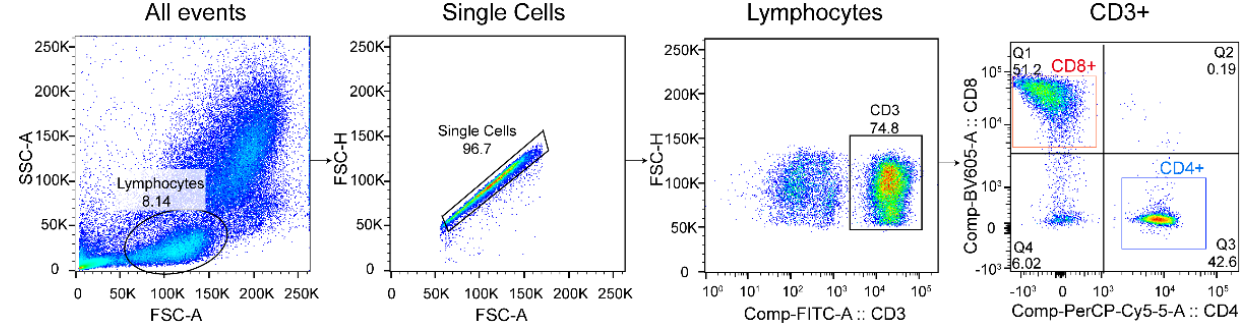
Figure 1. Example lineage gating strategy using pseudocolor dot plots. Figure generated using Flow Jo.